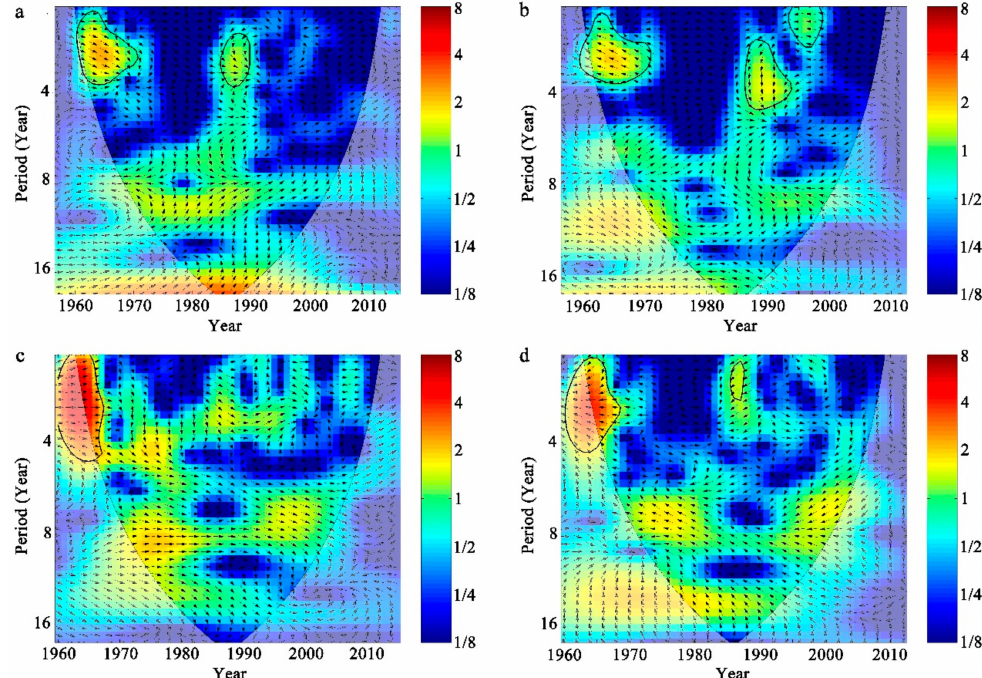
Figure 4. The cross wavelet transforms between precipitation and baseflow series in two watersheds: ( a ) is the Hailiutu River watershed (HLTR), ( b ) is the Dali River watershed (DLR); the cross wavelet transforms between reference evapotranspiration and baseflow series in two watersheds: ( c ) is the HLTR, ( d ) is the